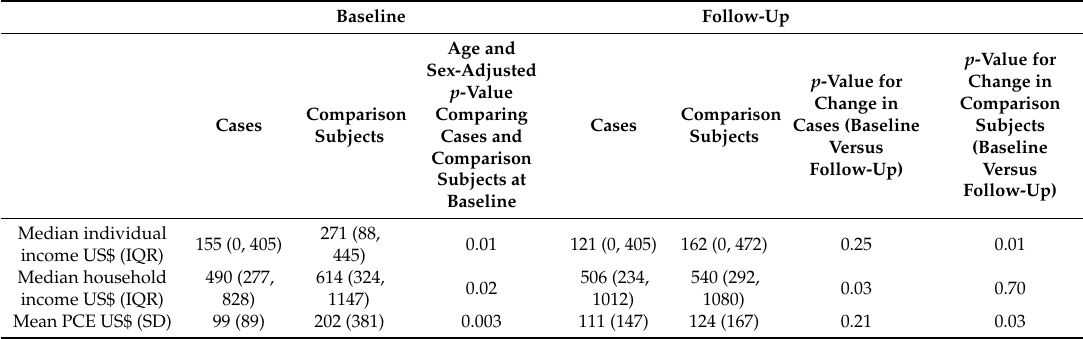
Table 2. Income and per-capita expenditure of cases and comparison subjects, at baseline and